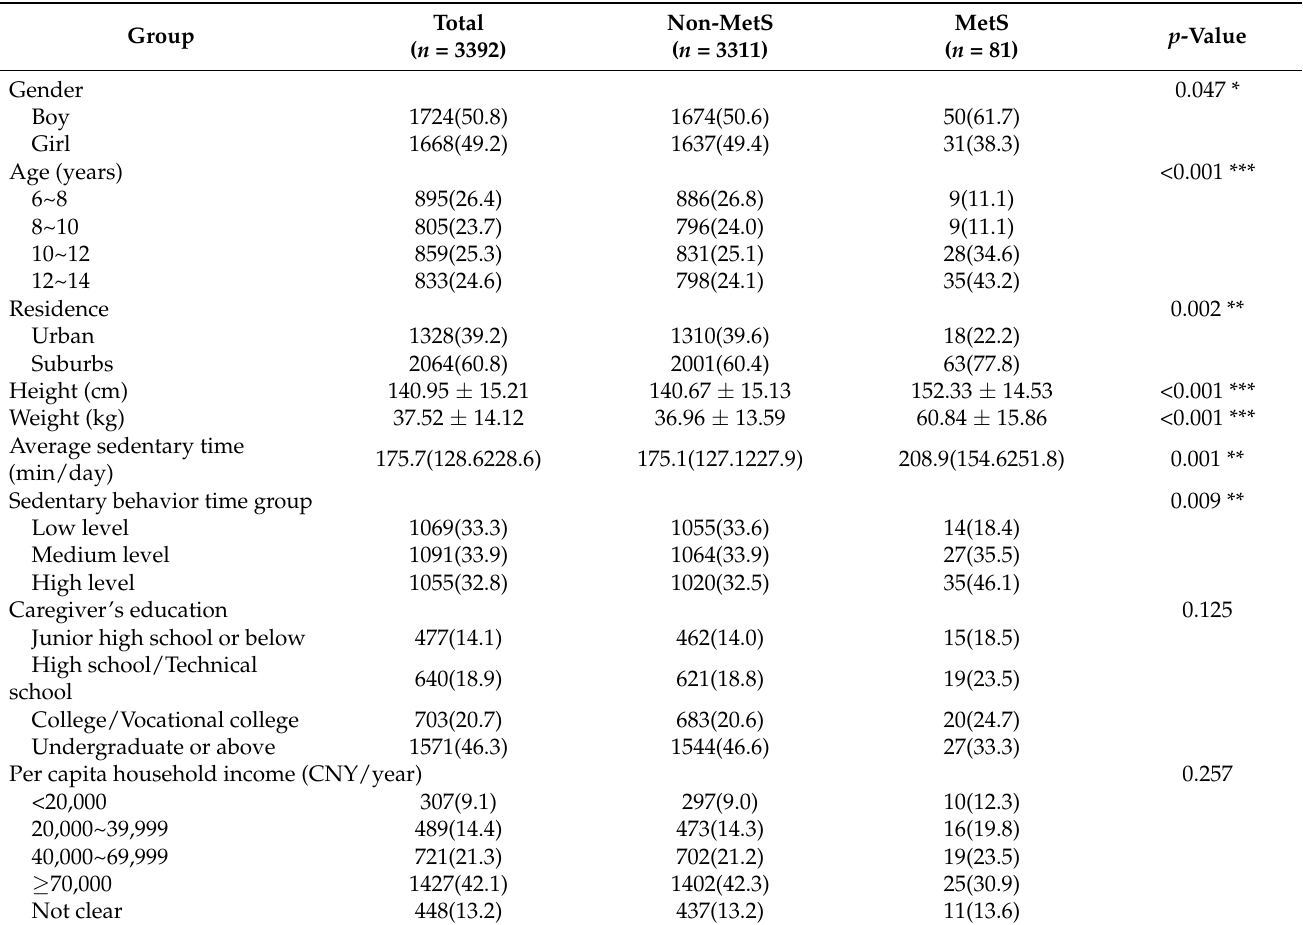
Table 1. Characteristics of participants by MetS